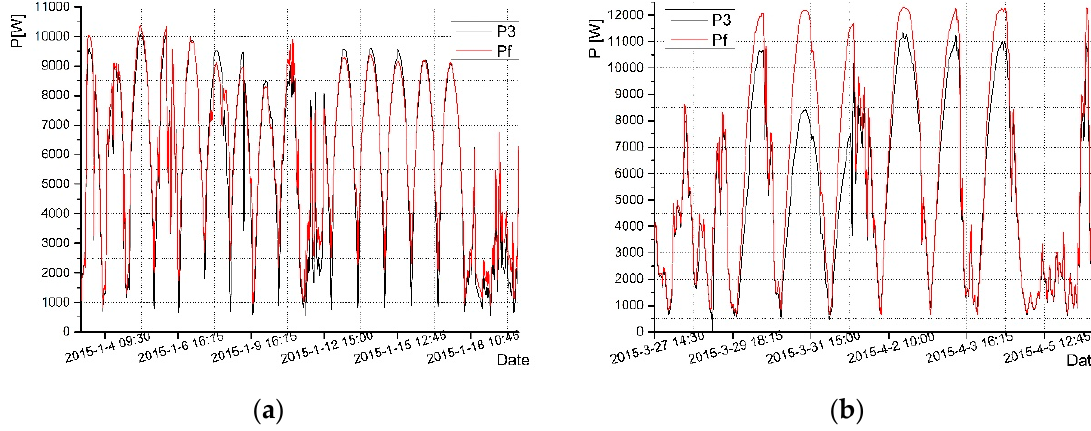
Figure 7. Comparison between the actual power output and simulated values for different seasons of the year 2015: ( a ) in January and ( b ) in March–April.